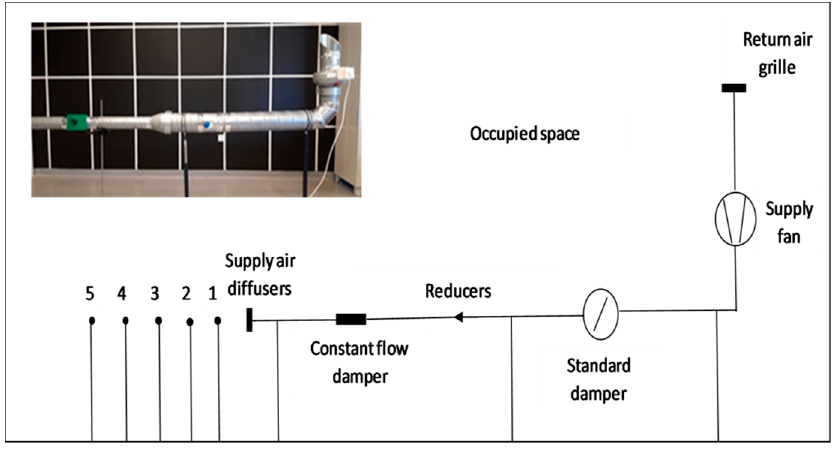
Figure 2. Testing equipment for air terminal devices.